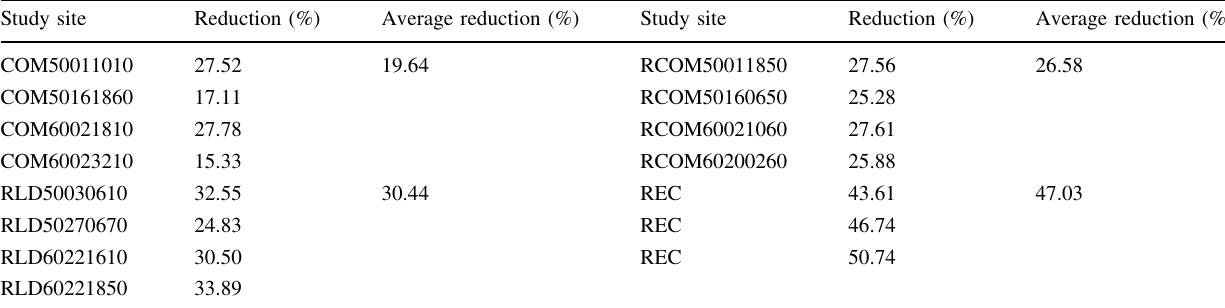
Table 4 Percentage reduction in 24-h traffic volume during winter months Study